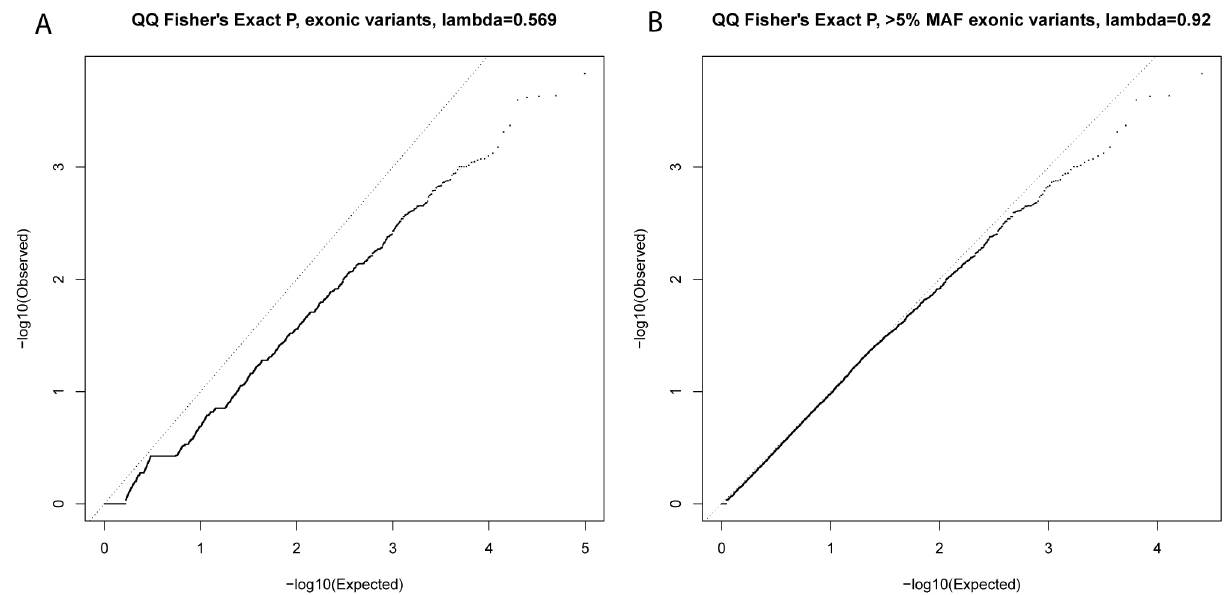
Figure 2. QQ plots of single-variant association test statistics for all exonic variants (A) and for exonic variants with MAF . 5% (B). doi:10.1371/journal.pgen.1004314.g002 PLOS Genetics |